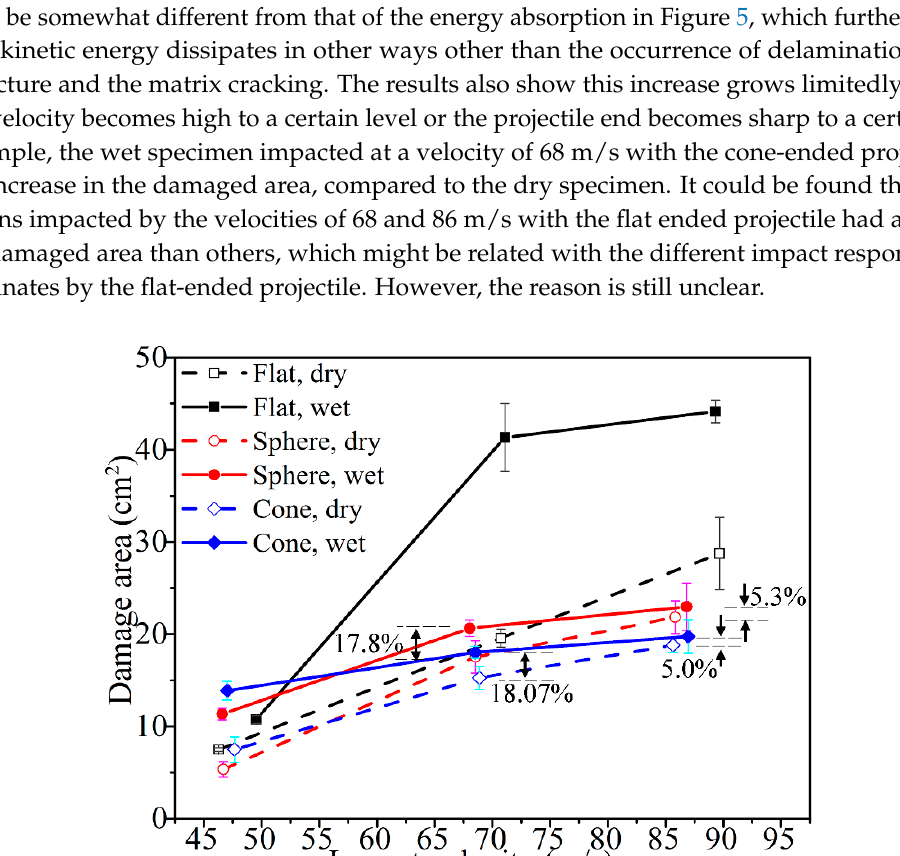
Figure 13. Impact-damaged images of the dry specimen subjected to the impact velocity of 45 m/s using the 3D-SDDM technique.